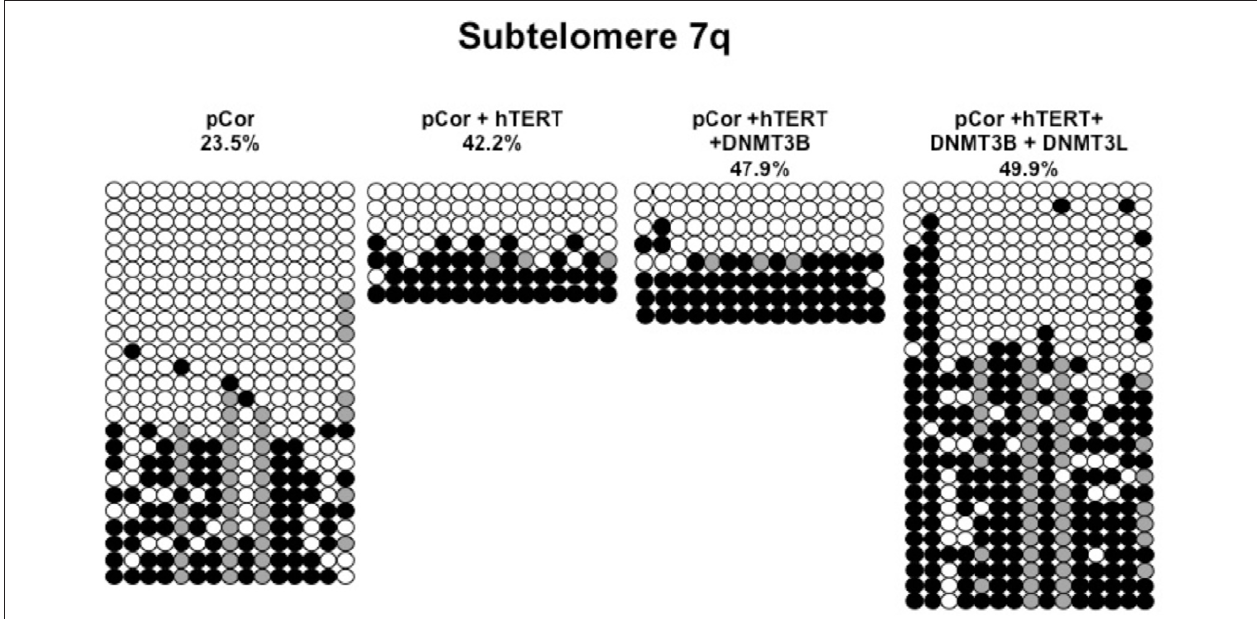
FIGURE A5 | Bisulfite analysis of subtelomeric region 7q. Bisulfite sequence analysis was carried out for a region in subtelomere 7q in pCor, pCor + hTERT, pCor + hTERT + DNMT3B1 and pCor + hTERT + DNMT3B1 + DNMT3L fibroblasts. The analyzed region contains 15 CpG sites. White circles represent unmethylated CpG